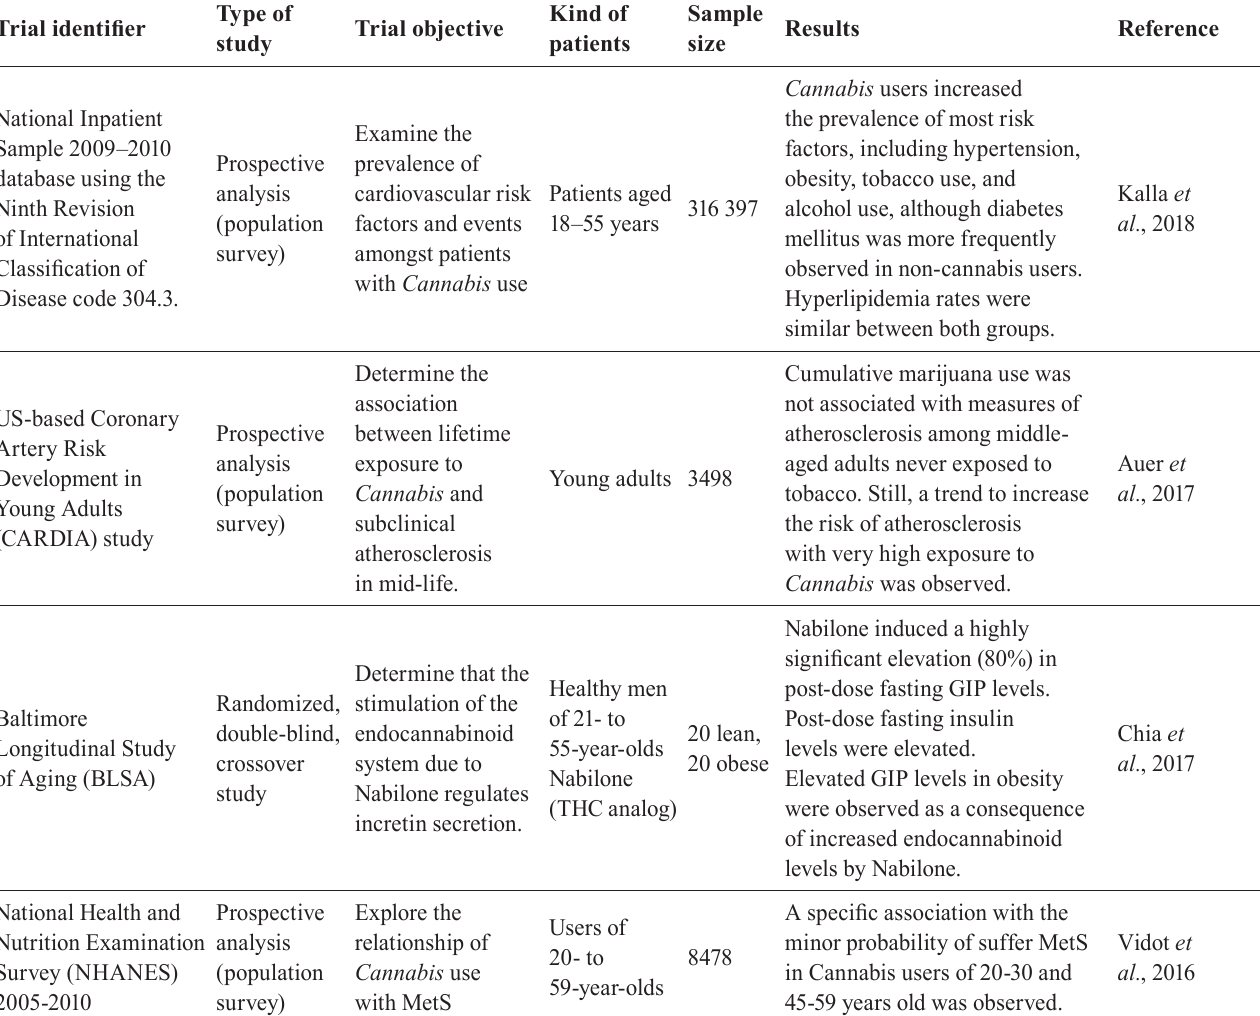
TABLE VIII - Recent clinical studies with Cannabis use in MetS and associated